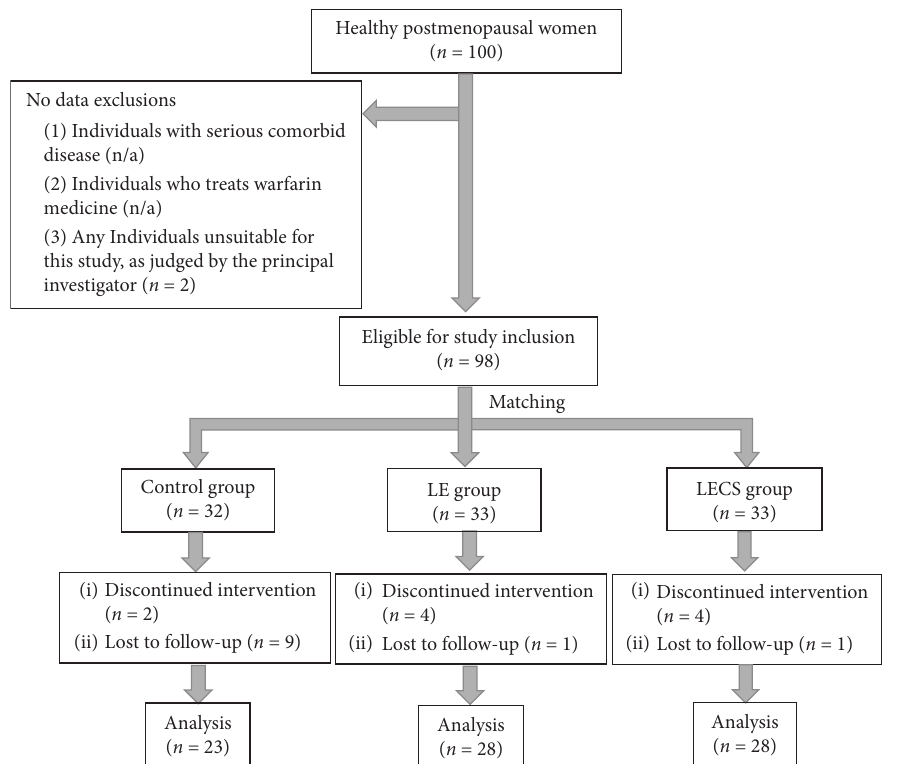
Figure 1: Study enrollment flowchart. The LE group received a nonsupplemented lemon beverage containing citric acid. The LECA group received a lemon beverage containing citric acid supplemented with